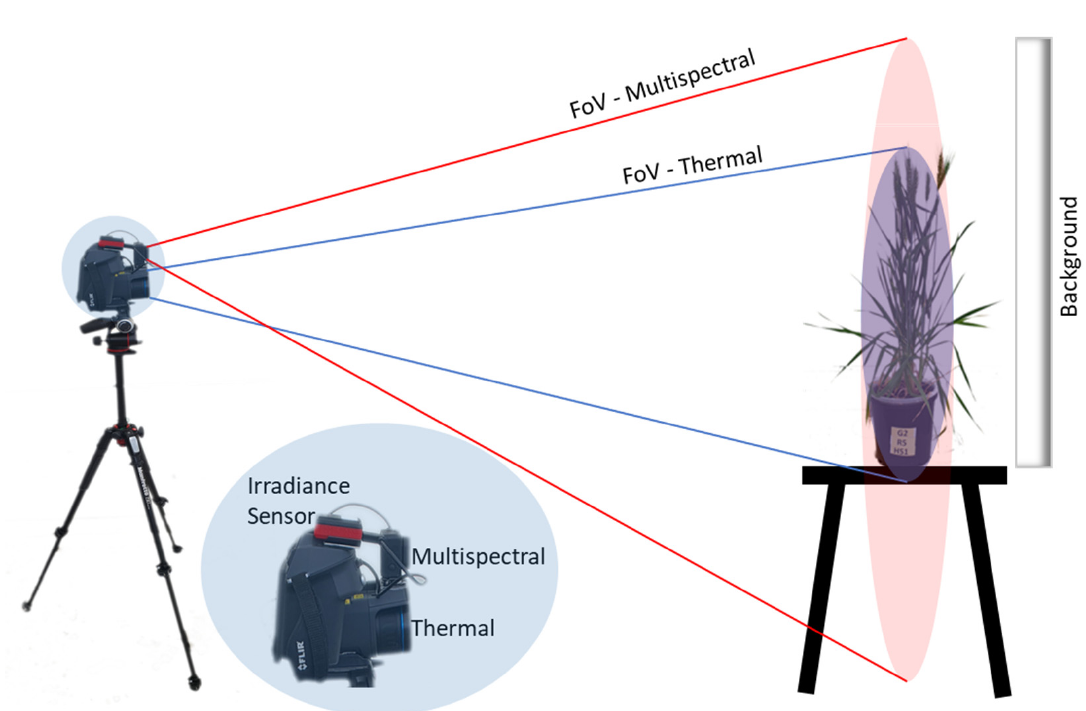
Figure 1. Integrated multimodal and imaging setup. A multispectral camera was physically mounted on the top of a thermal camera using a magnetic mount assembly to provide a uniform field-of-view (FoV). The irradiance sensor was mounted on the top. During imaging, a radiometric calibration target with 80 percent reflectivity was placed behind the plants.